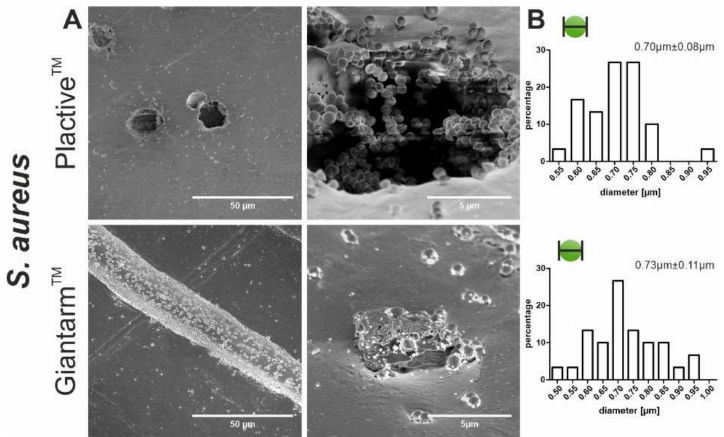
Figure 3. Scanning electron microscopy (SEM) images showing the biofilm formation and size measurement of S. aureus . ( A ) The two top SEM images depict the formation of biofilm on Plactive™ PLA, and the two bottom images depict the biofilm formation on Giantarm™ PLA. ( B ) The top graph visualizes the size distribution of the bacteria on Plactive™ PLA, and the bottom graph visualizes the size distribution of the bacteria on Giantarm™ PLA. For all graphs, the y axis represents the relative percentage and the x axis represents the radius of the bacteria in microns.